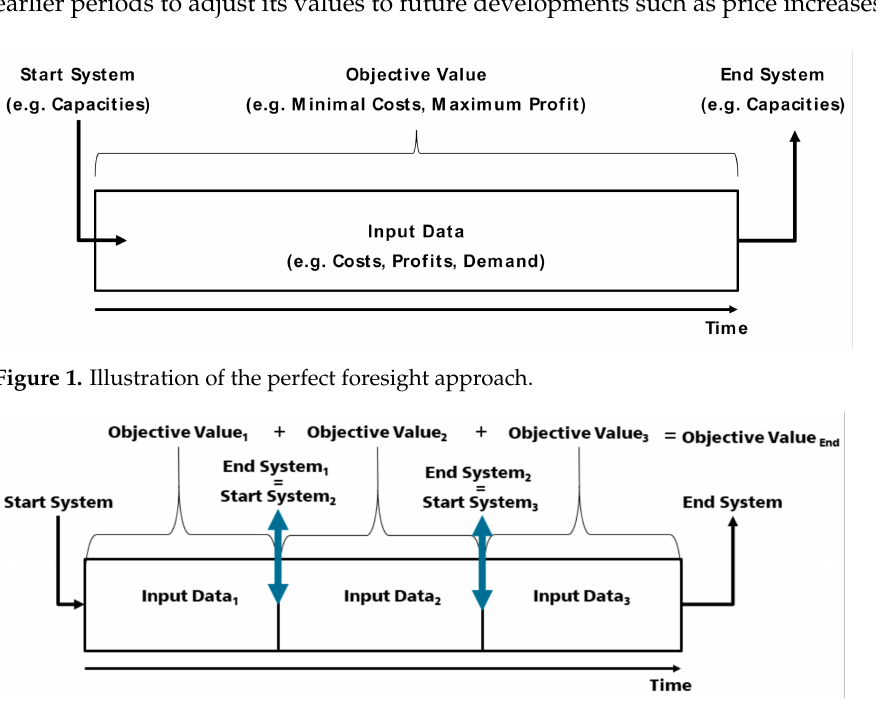
Figure 2. Illustration of the myopic recursive approach, where the optimization problem is divided into several smaller optimization problems that are optimized consecutively without information about future